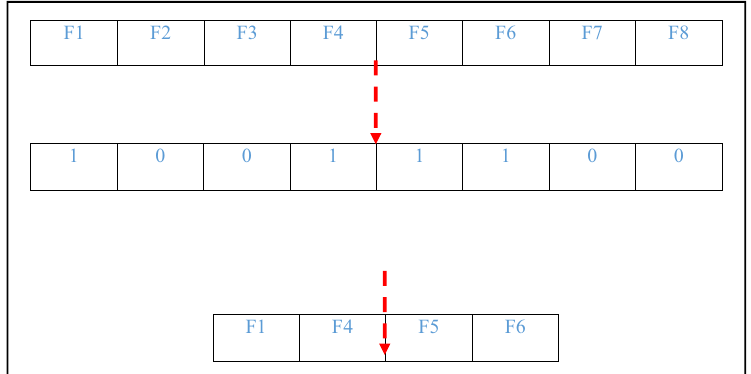
Figure 1: The selected